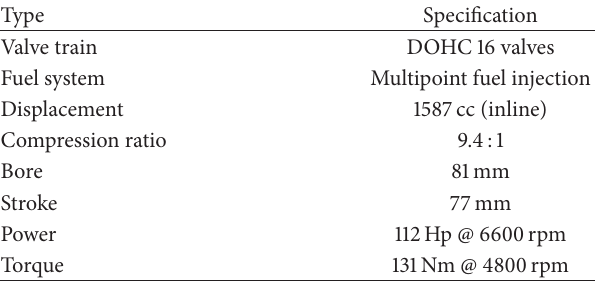
Table 1: Specifications of the test